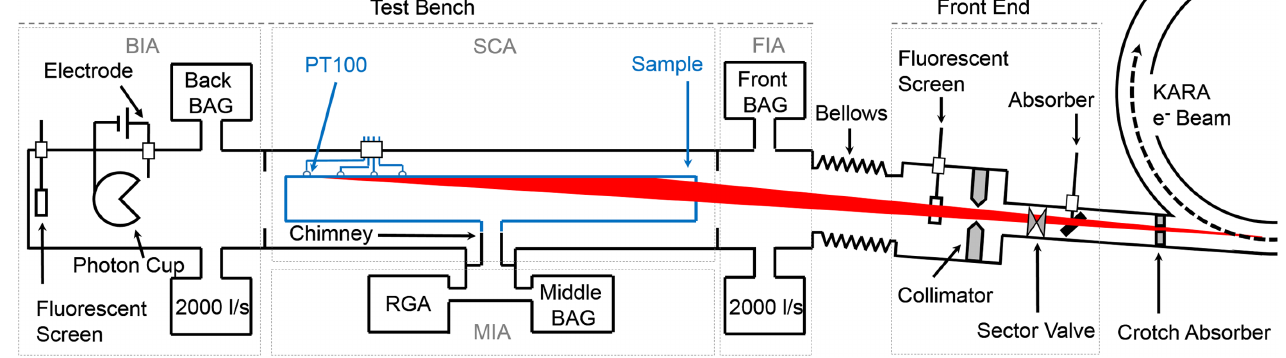
FIG. 2. Schematic layout of the BESTEX.